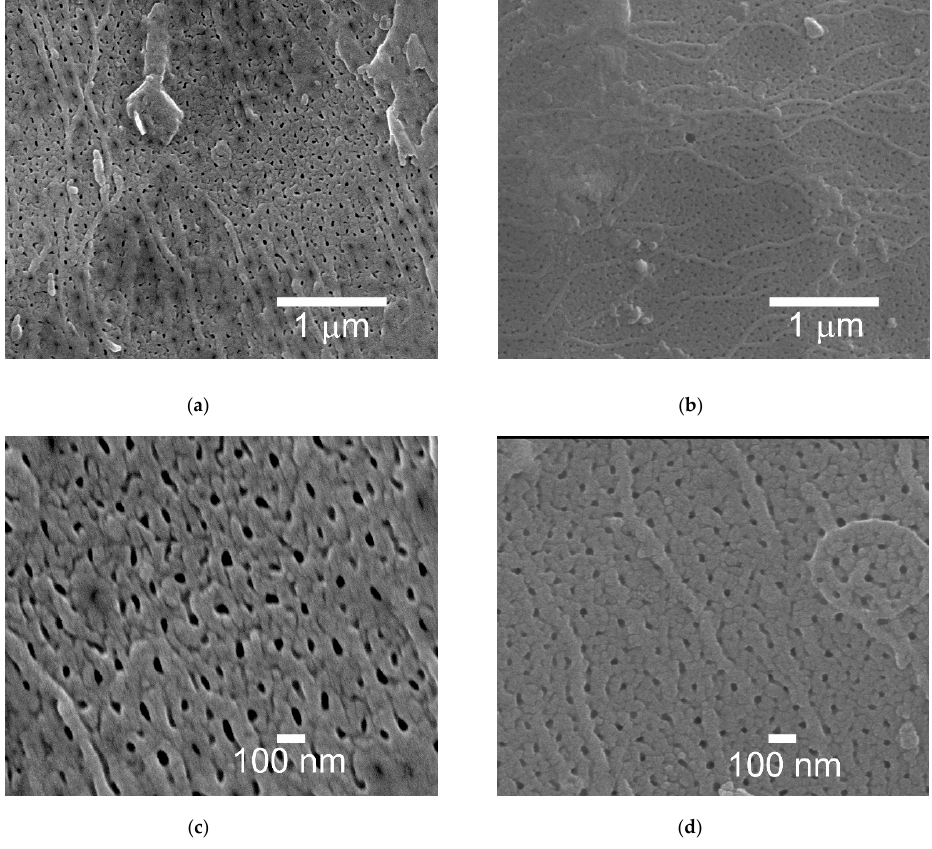
/ IF-WS 2 O 3 and ( b ) Al 2 O 3 2 .